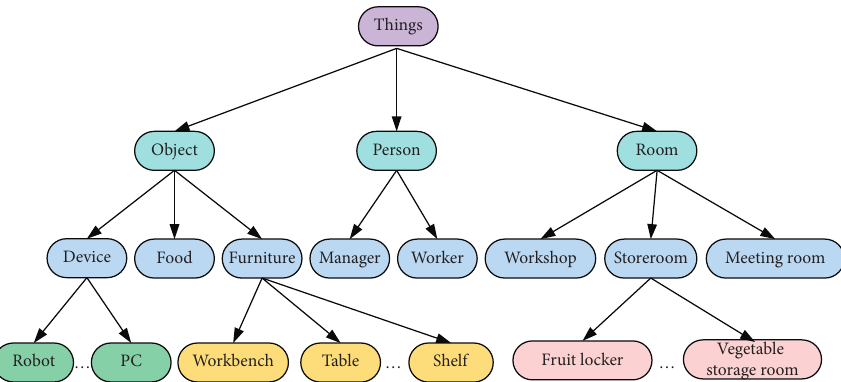
Figure 4: Hierarchical relationship of concepts.